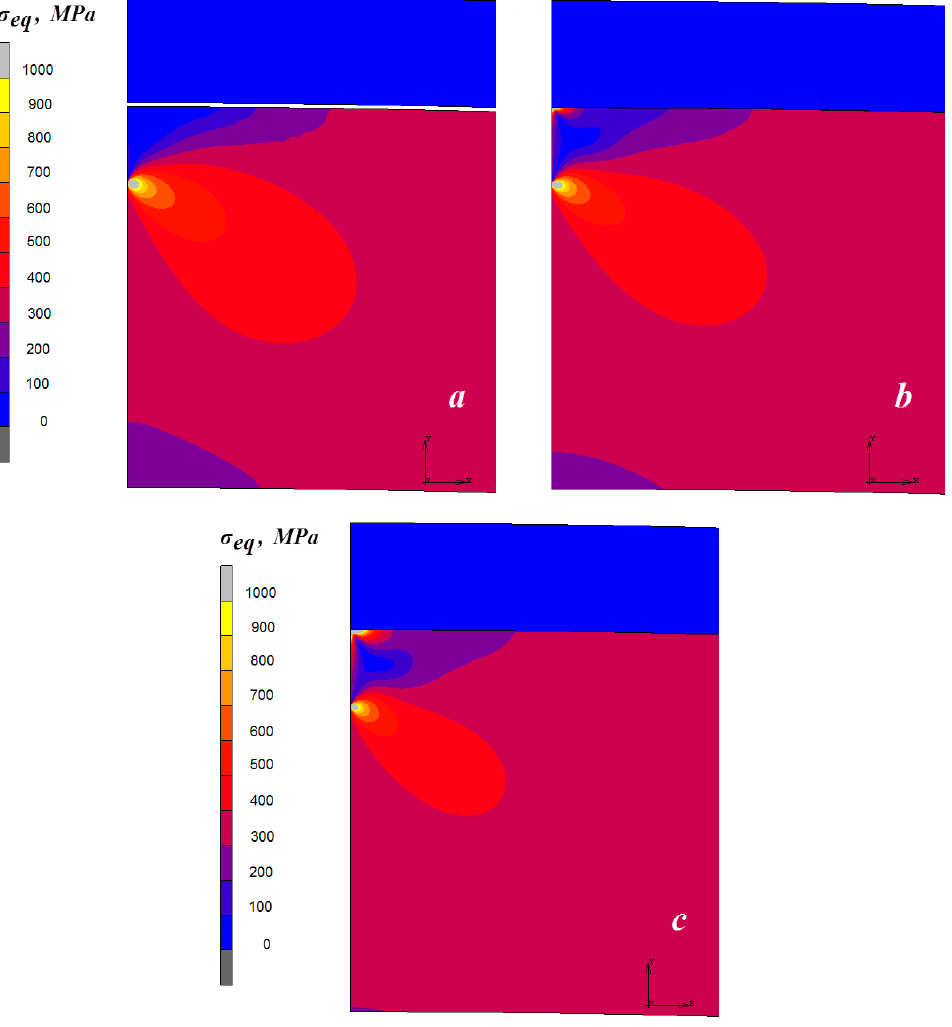
= p = 10 MPa, ( b ) repair